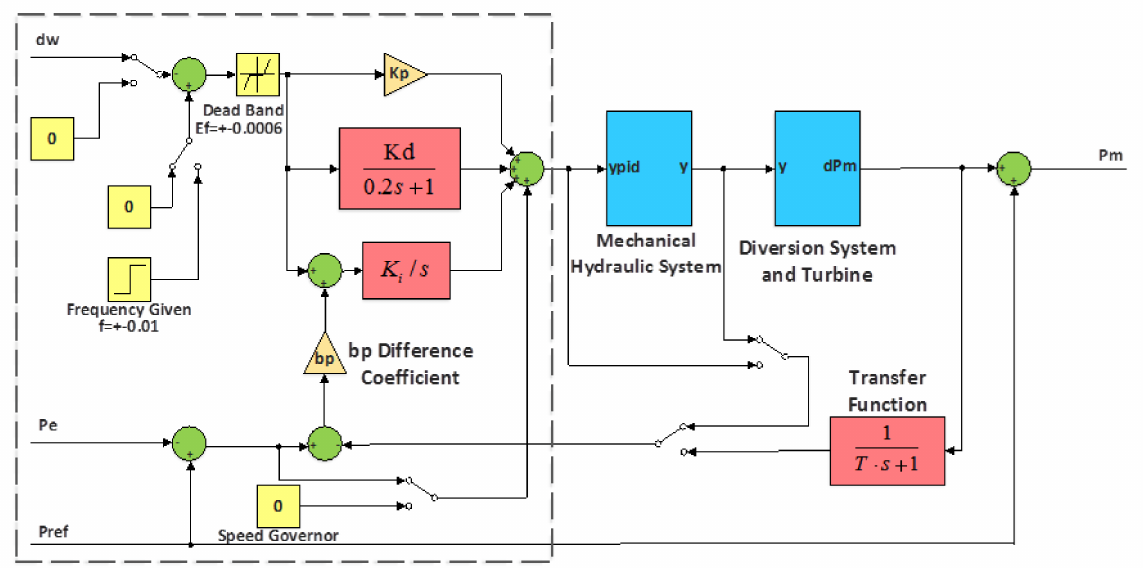
Figure 6. Block of an integrated hydropower